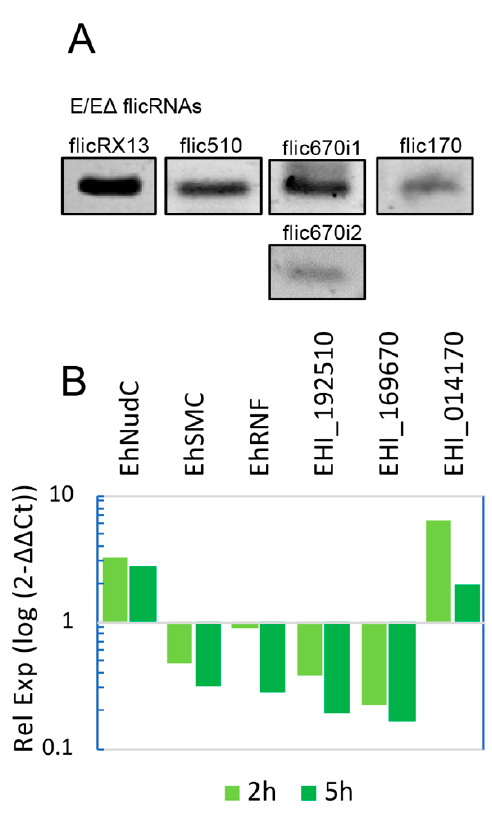
Figure 4. flicRNAs are found on the promoters of their parental genes and alter the expression of flicRNA-forming and no flicRNA-forming genes. ( A ) RNA was extracted from ∆ E fractions of HA-Pol II ChIP aliquots and used to perform circular RT-PCR to detect immunoprecipitated flicRNAs. ( B ) After 2 h or 5 h boric acid-induced flicRNA production reduction, the expression of the non-flicRNA-forming genes, EhNudC, EhSMC, and EhRNF (2 h sample only), and the flicRNA-forming genes, EHI_192510, EHI_169670, and EHI_014170, was analyzed by RT-qPCR, compared to untreated control amoebas, set as 1 in each case . The logarithmic plot shows that all expression profiles are statistically significant (ANOVA and Turkey test a posteriori. p ≤ 0.01).